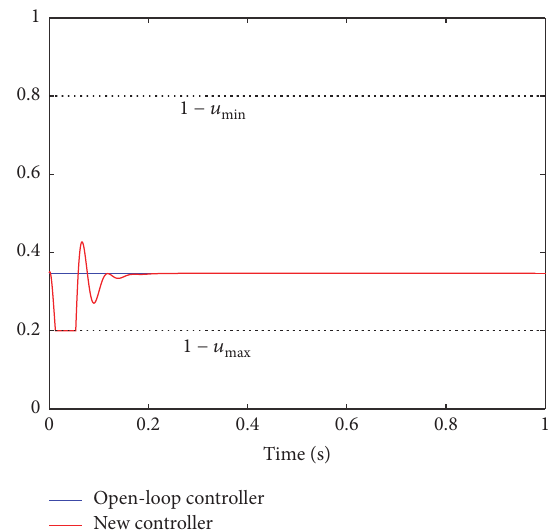
Figure 3: Duty cycle percentage 𝑢(𝑡) obtained for the new controller (17) and (18) and the open-loop controller